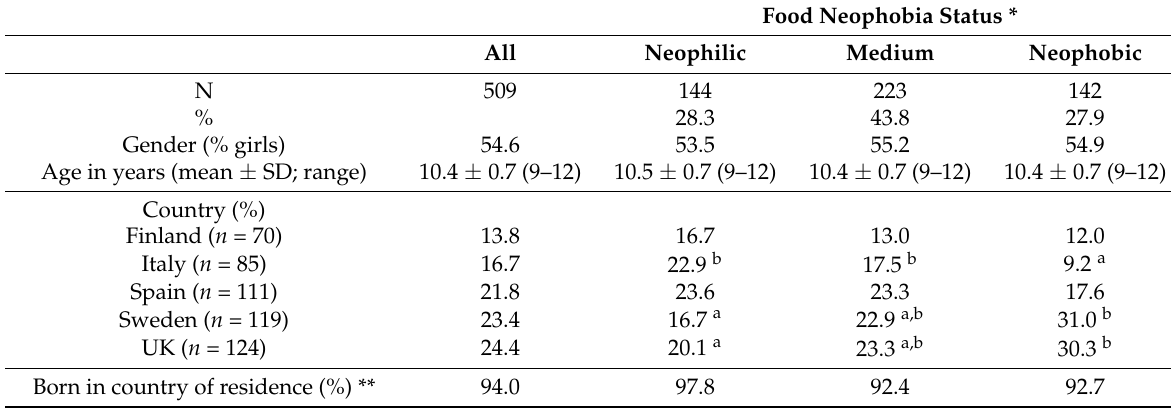
Table 3. Background characteristics and food neophobia status of the participating